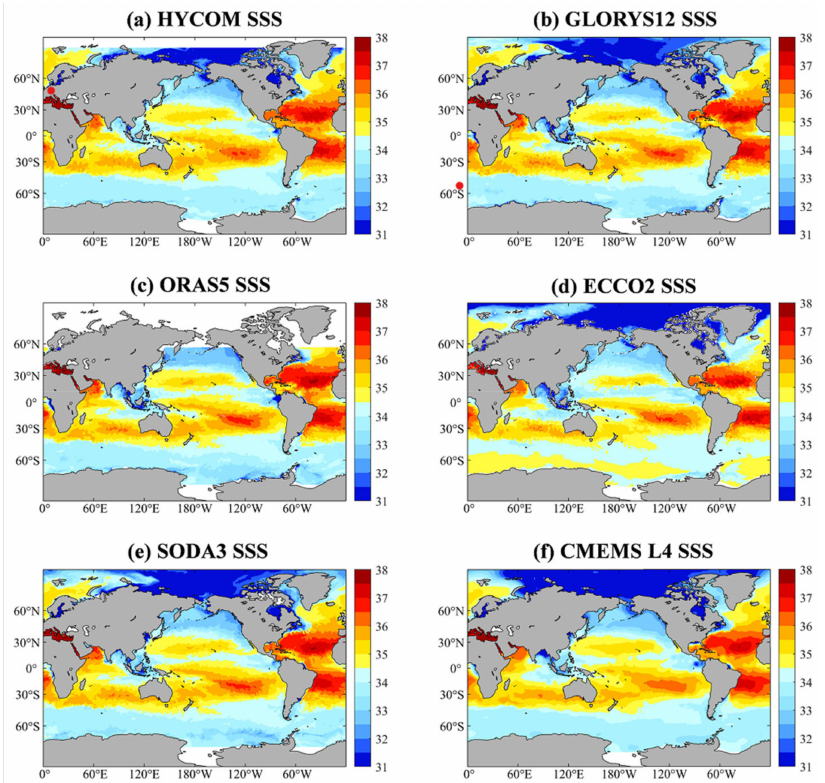
Figure 6. Global SSS maps for ( a ) HYCOM, ( b ) GLORYS12, ( c ) ORAS5, ( d ) ECCO2, ( e ) SODA3 and ( f ) CMEMS L4 product at June 2017. The unit is in